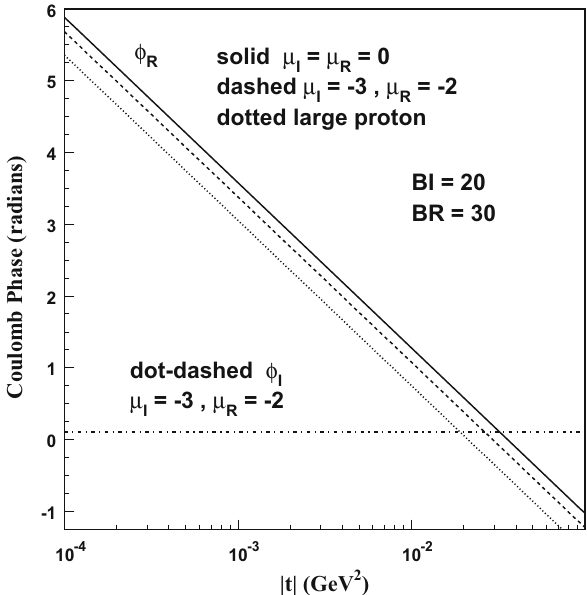
Fig. 8 Phase of the Coulomb–Nuclear interference with examples for the values of the parameters. We plot also the phase calculated with (cid:8) 2 = 0 . 71 / 2 GeV 2